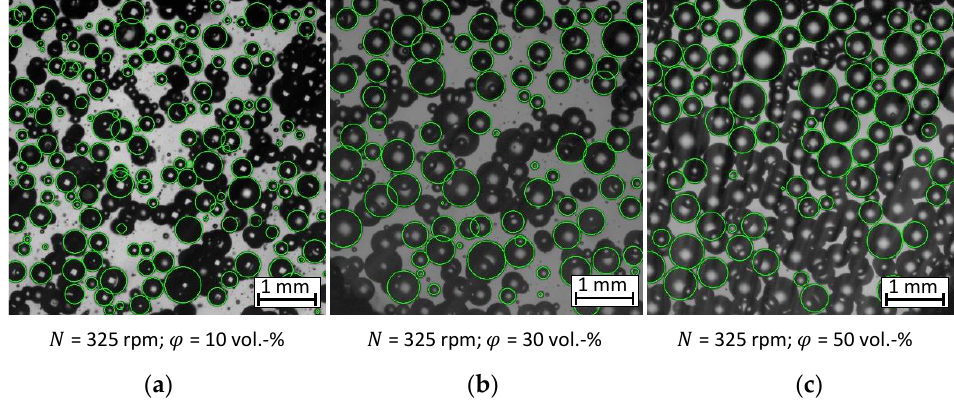
Figure 4. CNN analysis at different phase fractions at 𝑁 = 325 rpm. ( a ) 10 vol.-%, ( b ) 30 vol.-% and ( c ) 50 vol.-%. The green circles represent the detected droplet circumference.